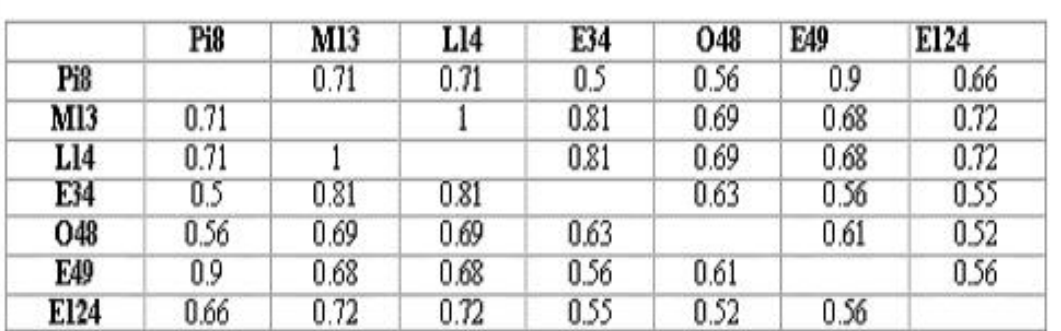
Figure 5. Dendrogram based on the S coefficients showing the genetic similarity ab developed from RAPD-PCR standards of Klebsiella pneumoniae with primer Operon 18 by Sorensen-Dice coefficient. S average indicated by the dotted line. ab Pi: isolates from lavatory basin; L: isolates from gloves; O: isolates from eyeglasses; E: isolates from hand skins of surgeon-dentists; M: isolates from